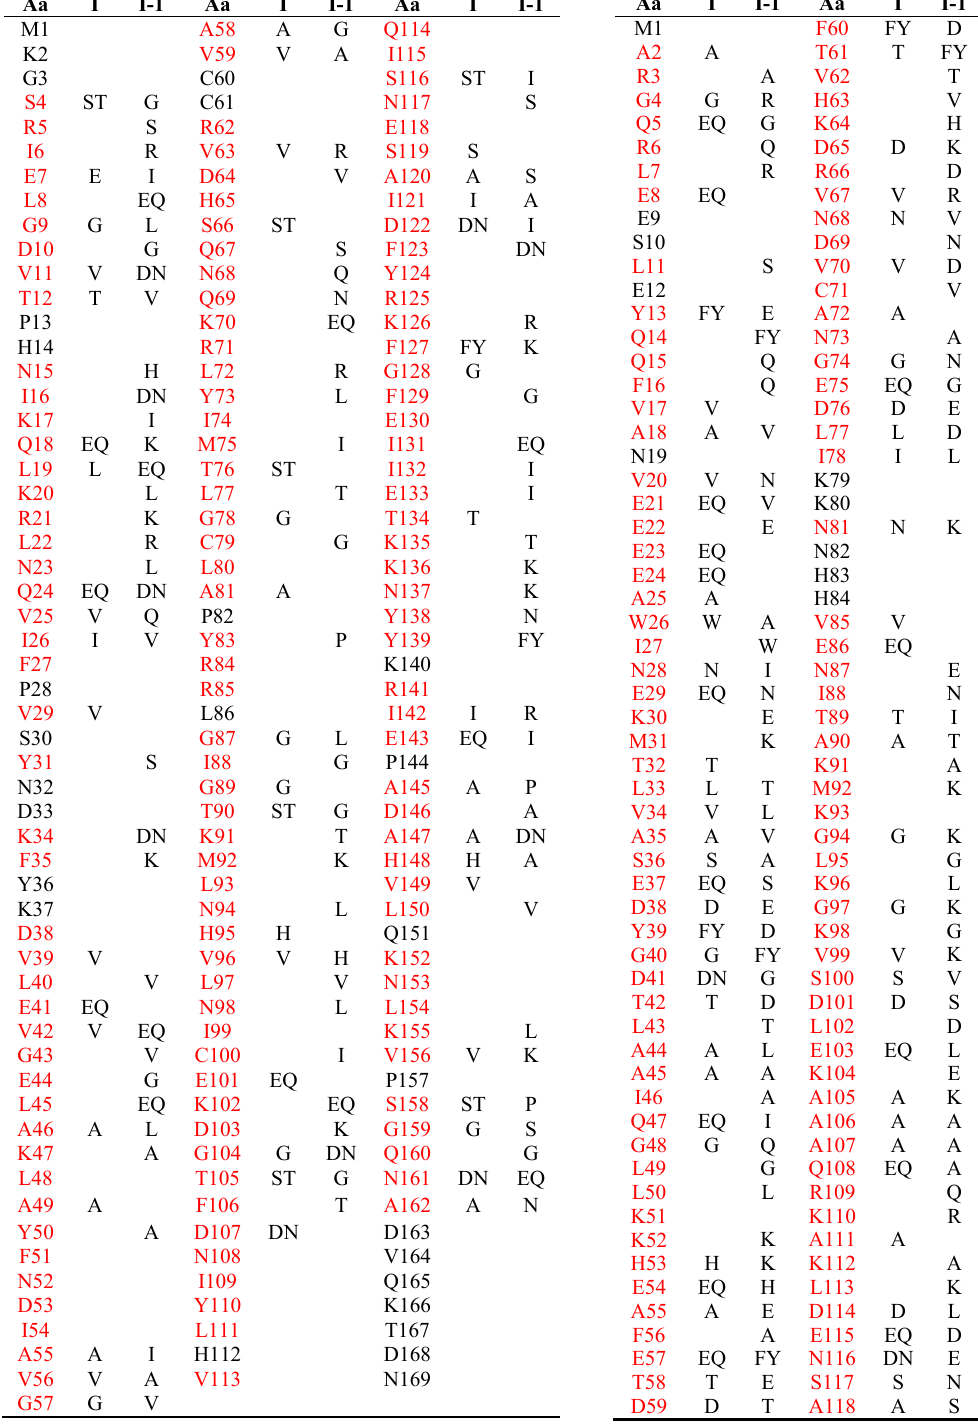
Table 4. Overview of the amino acid sequences of hNaa50p ( a ) and R17 ( b ). Amino acids with assigned HN-peaks are highlighted. The columns denoted I and I-1 refer to the amino acid identity determined by the aliphatic chemical shifts and MUSIC experiments. Most unassigned residues are prone to exchange broadening. Note that the approach also works in stretches with repetitive amino acids ( 21 EEEE 24 and 105 AAA 107 in